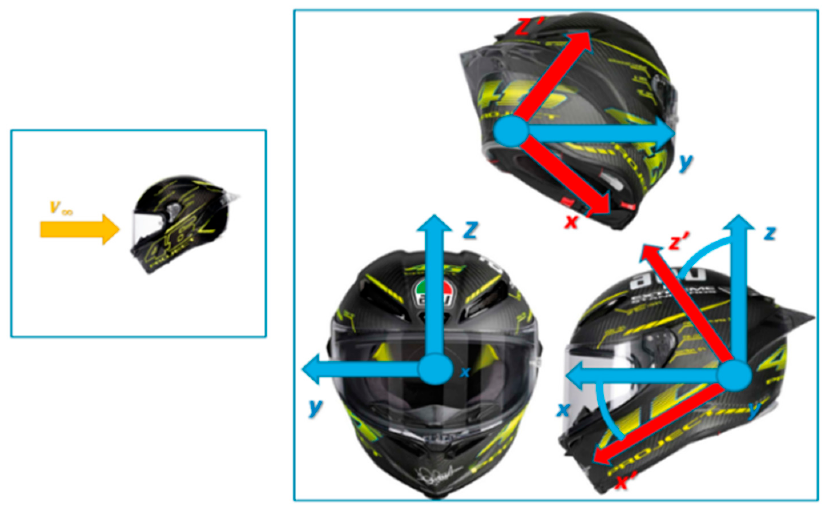
Figure 3. Alignment of the helmet with respect to the wind current.